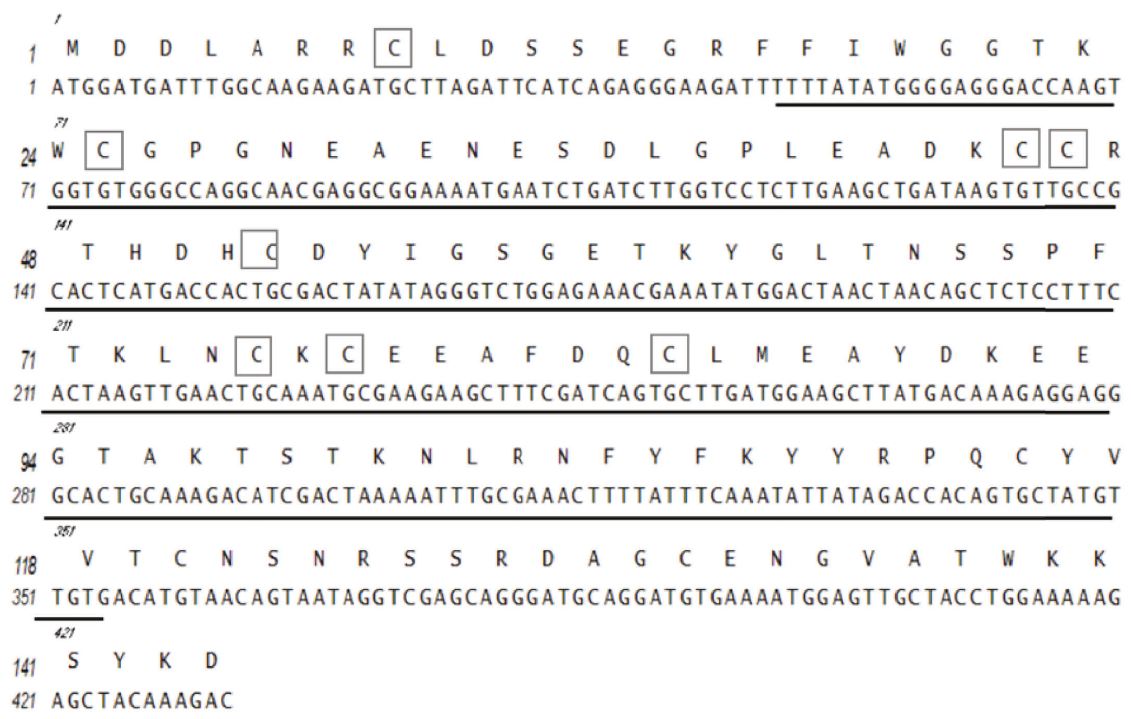
Figure 5: Nucleotides and predicted amino acid sequence of Maurolipin. Nucleotide and amino acid numbers appeared on the left. The middle-letter at above the nucleotide sequence is coded amino acid sequence. The disulfide bonds between cysteine residues in the protein structure have been signed by black boxes. The conserved domains of Maurolipin amino acid length with PLA shown by black line.